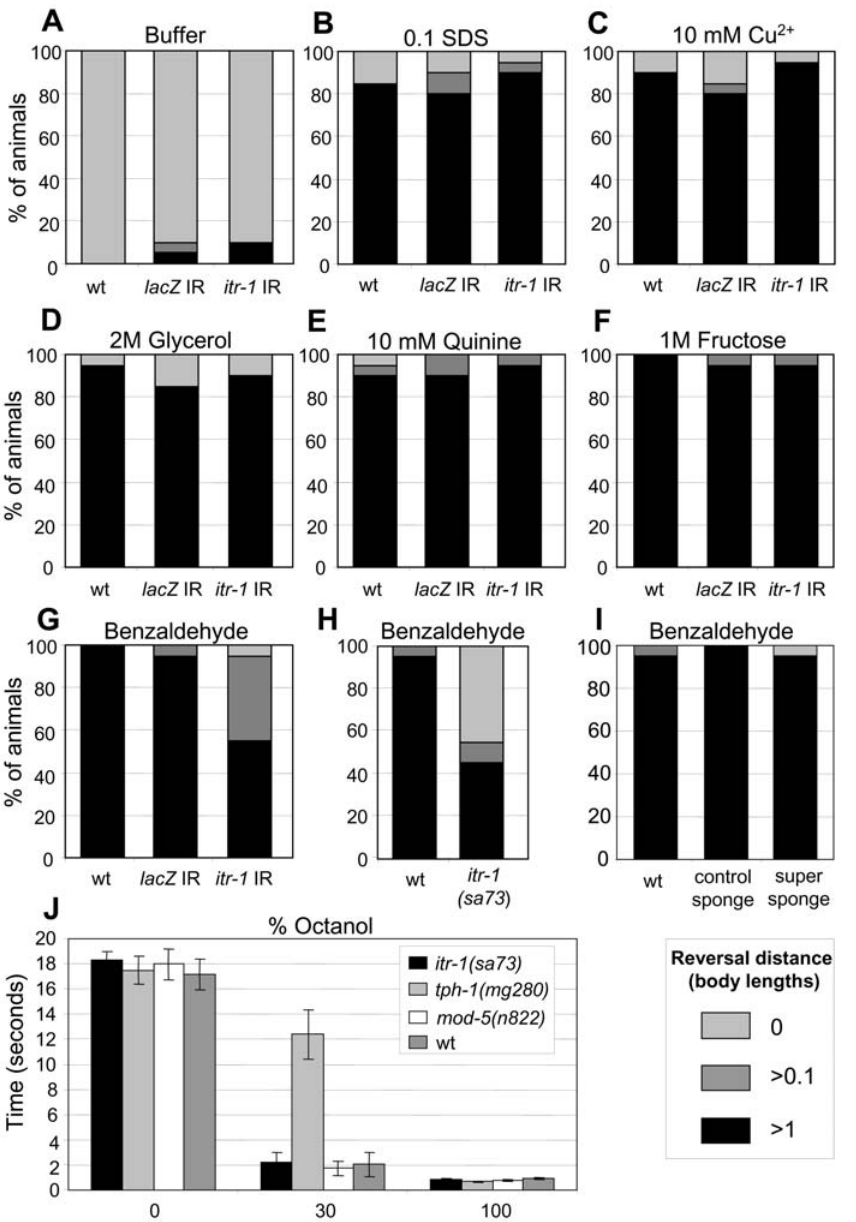
Figure 3. itr-1 functions in the avoidance response to a volatile repellent, benzaldehyde, but not in other ASH-mediated responses. (A–I) The reversal response of animals (measured in worm lengths; see key, bottom right) exposed to a range of stimuli. (A–F) Reversal responses in animals expressing itr-1 or lacZ dsRNA (IR, inverted repeat) under the control of the unc-119 promoter and treated with: (A) Buffer alone (30 mM Tris [pH 7.5], 100 mM NaCl, 10 mM KCl), (B) SDS, (C) copper, (D) glycerol, (E) quinine, and (F) fructose, at the concentrations indicated, using a ‘‘dry